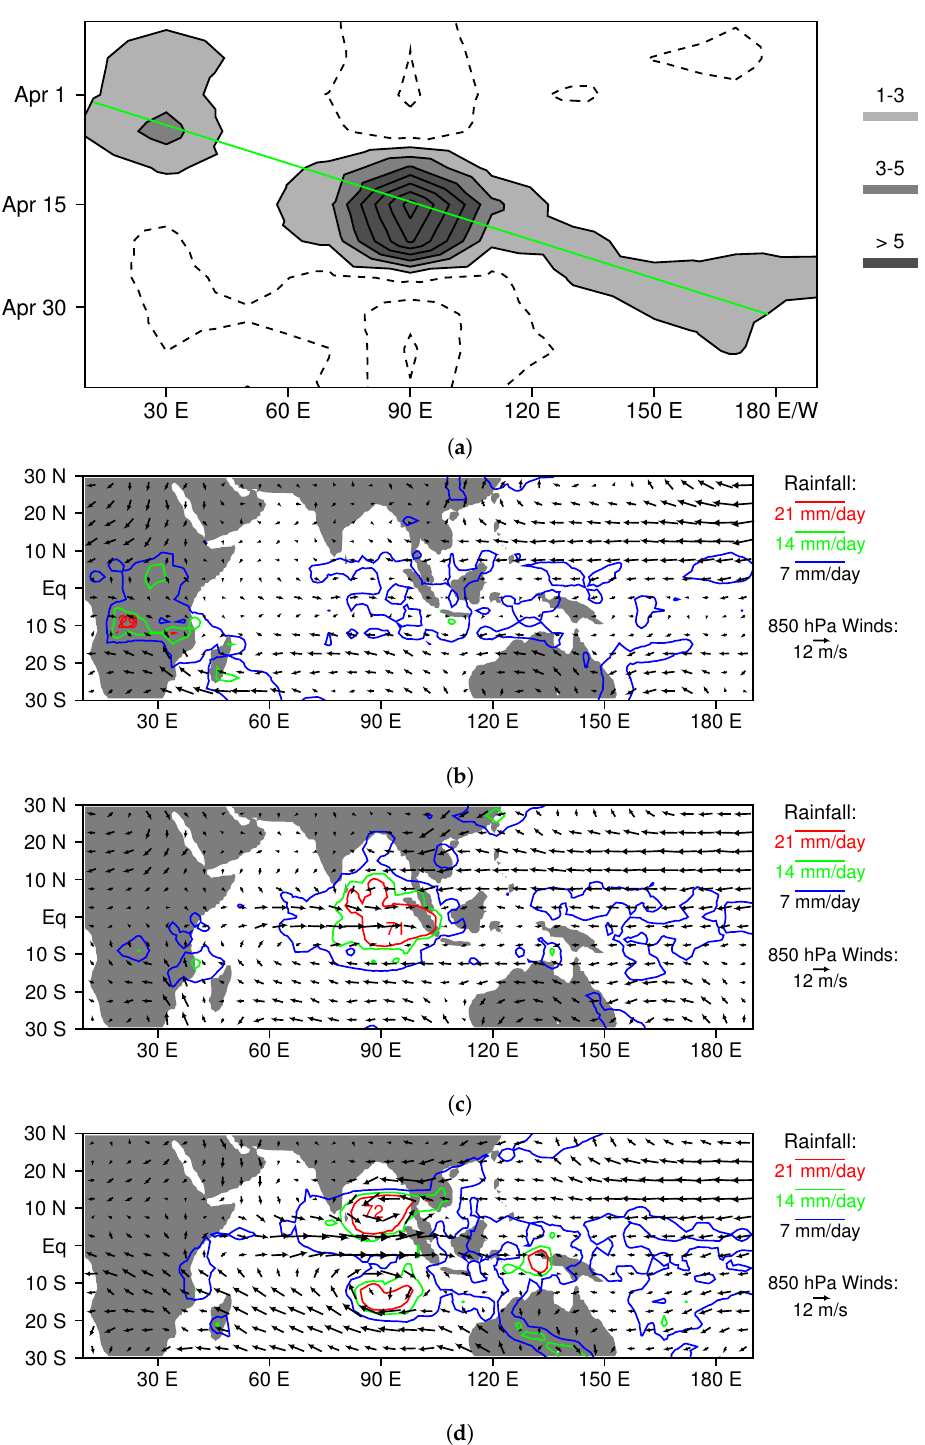
Figure 10. Horizontal structure and propagation of the April 1998 MJO simulated with the higher-resolution version of the LAM. ( a ) time series of time-filtered equatorial (15 S–15 N) rainfall; ( b – d ) rainfall and 850 hPa winds for 5 April, 12 April, and 21 April,